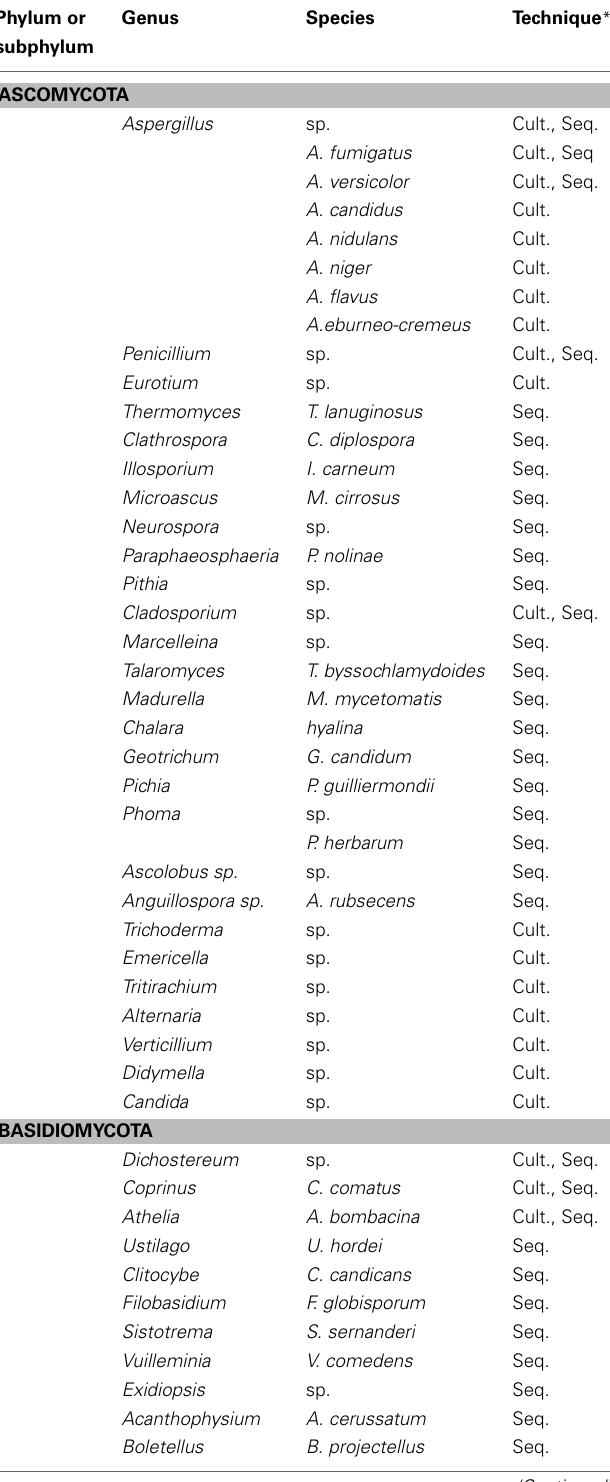
Table 2 | Dominant fungi identified in aerosols from composting facilities using culture-dependent and culture independent techniques from Le Goff et al. (2010), Bru-Adan et al. (2009), and ADEME